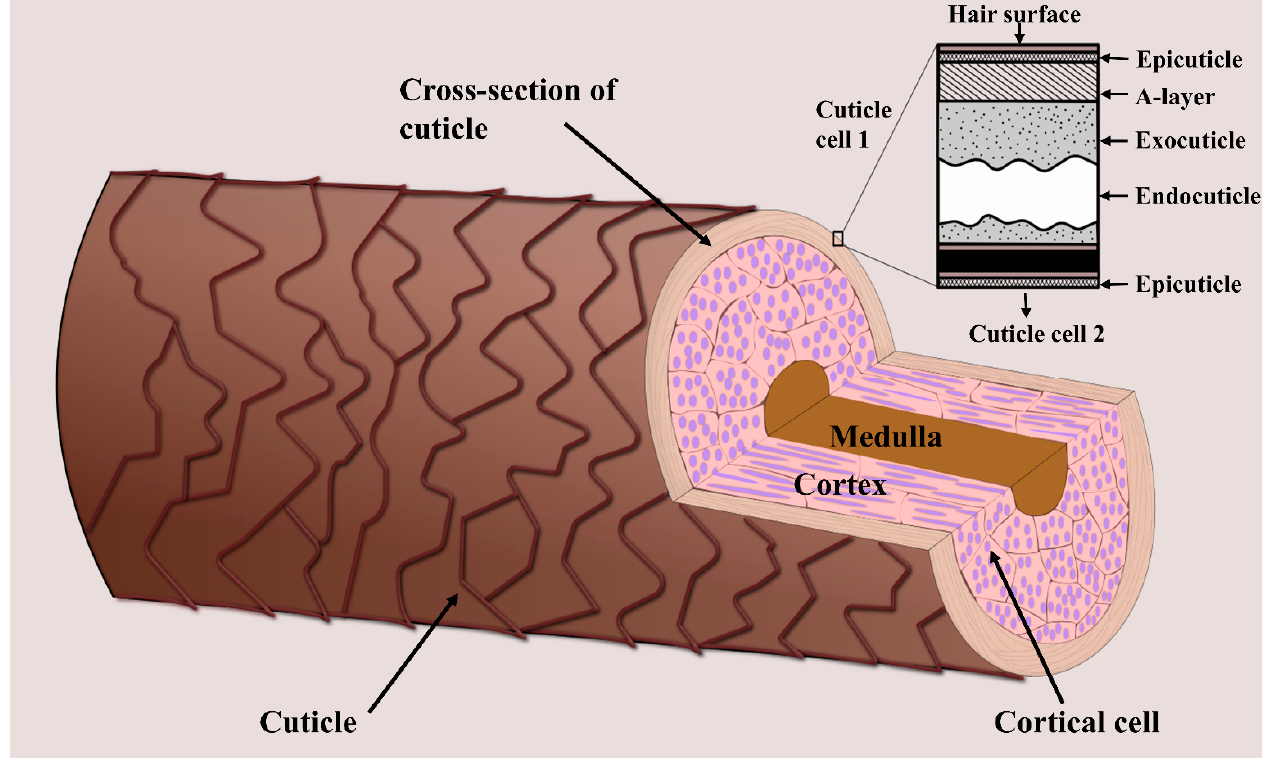
Figure 1. Schematic showing the three main layers of a hair strand—the cuticle, cortex, and medulla. The inner hair structure (i.e., the cortex and medulla) is surrounded by several layers of cuticle cells. The figure was created based on [18].